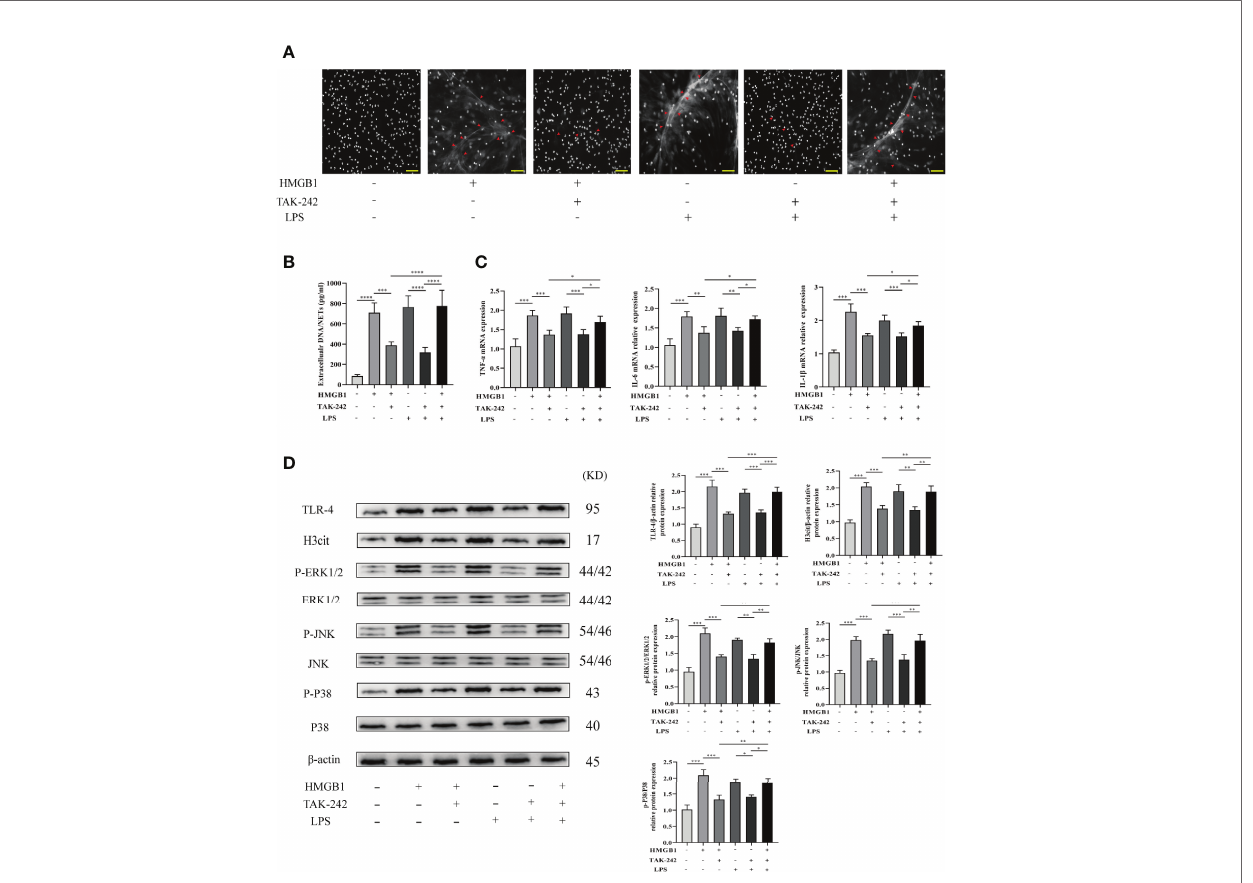
FIGURE 6 | TAK-242 suppresses the MAPK signaling pathways and alleviates NET deposition in rat liver transplantation. (A) Following transplantation, NETs were stained with DAPI in the livers of rats (magni fi cation, ×200; scale bar = 100 m m). (B) Quanti fi cation of extracellular DNA/NETs in different groups. (C) The mRNA level of IL-1 b , TNF- a , and IL-6 in liver tissues from different groups. (D) Protein expression levels of MAPK signaling pathway factors. n = 6 for each group. ANOVA was used to determine the statistical differences between groups. * P < 0.05, ** P < 0.01, *** P < 0.001, **** P < 0.0001.